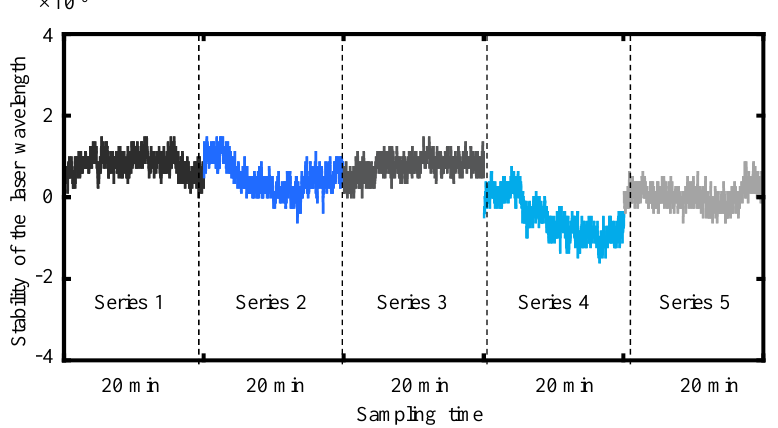
Figure 9. Repeatability of the laser diode wavelength measurements.